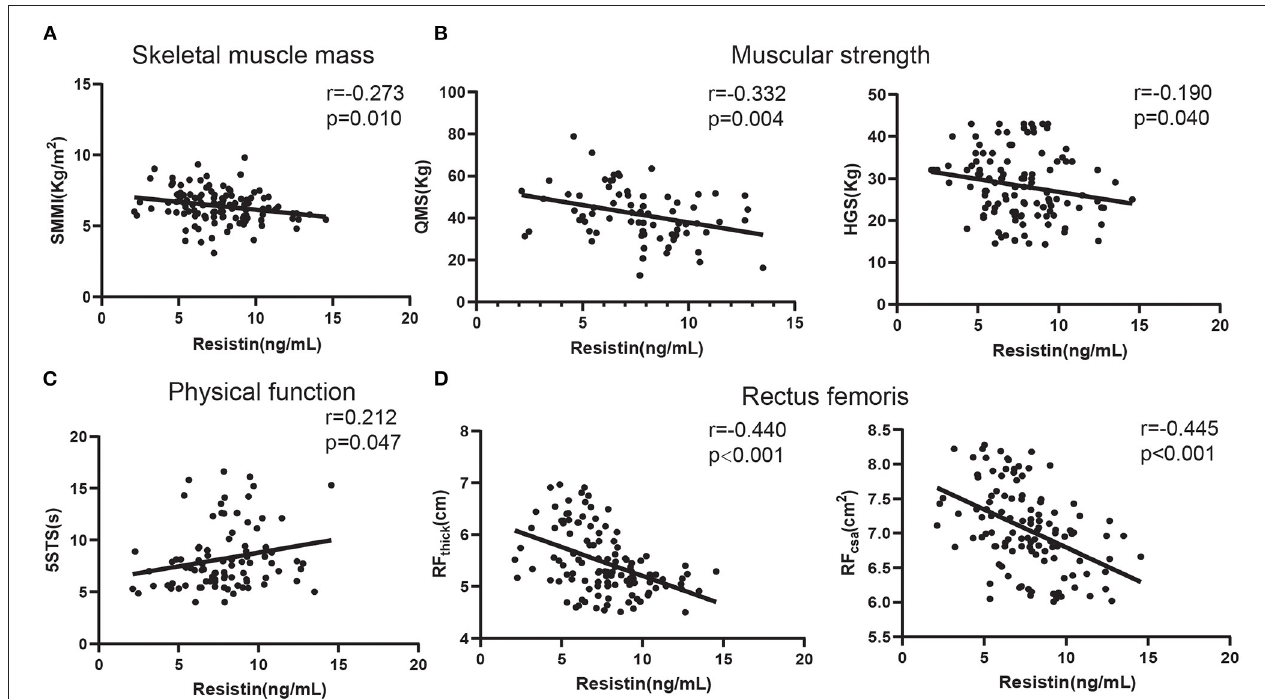
FIGURE 2 | The relationships of serum resistin levels with skeletal muscle function in patients with COPD. (A) The relationship between serum resistin levels and SMMI; (B) The relationship between serum resistin levels and QMS and HGS; (C) The relationship between serum resistin levels and 5STS; (D) The relationship between serum resistin levels and RF thick and RF csa .